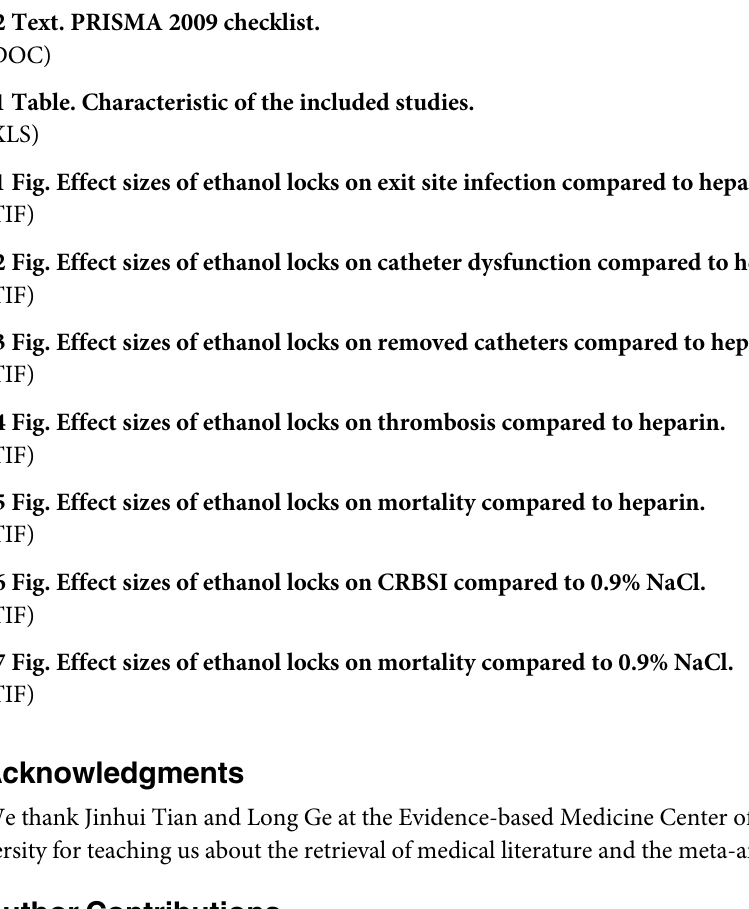
S1 Fig. Effect sizes of ethanol locks on exit site infection compared to heparin. S2 Fig. Effect sizes of ethanol locks on catheter dysfunction compared to heparin. S3 Fig. Effect sizes of ethanol locks on removed catheters compared to heparin. S4 Fig. Effect sizes of ethanol locks on thrombosis compared to heparin. S5 Fig. Effect sizes of ethanol locks on mortality compared to heparin. S6 Fig. Effect sizes of ethanol locks on CRBSI compared to 0.9% NaCl. S7 Fig. Effect sizes of ethanol locks on mortality compared to 0.9%